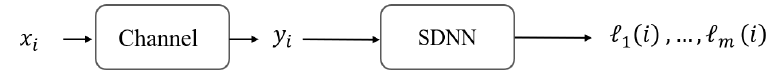
Figure 12. Soft DNN model training